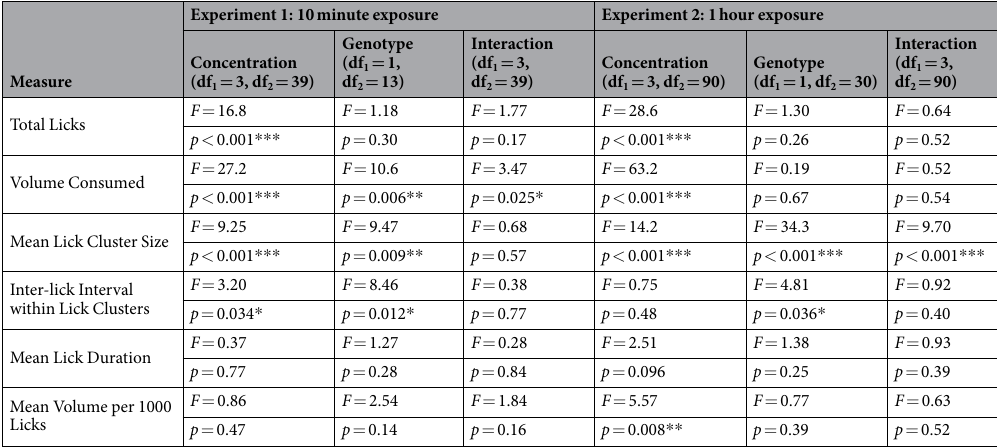
Table 1. Results of mixed-model ANOVAs of concentration (4%, 8%, 16%, or 32%) by genotype (WT or Gria1 − / − ), showing main effects of concentration and genotype, and the concentration x genotype interaction, for six measures of consumption behaviour in Experiments 1 and 2. Relevant degrees of freedom are given in the table headings (df